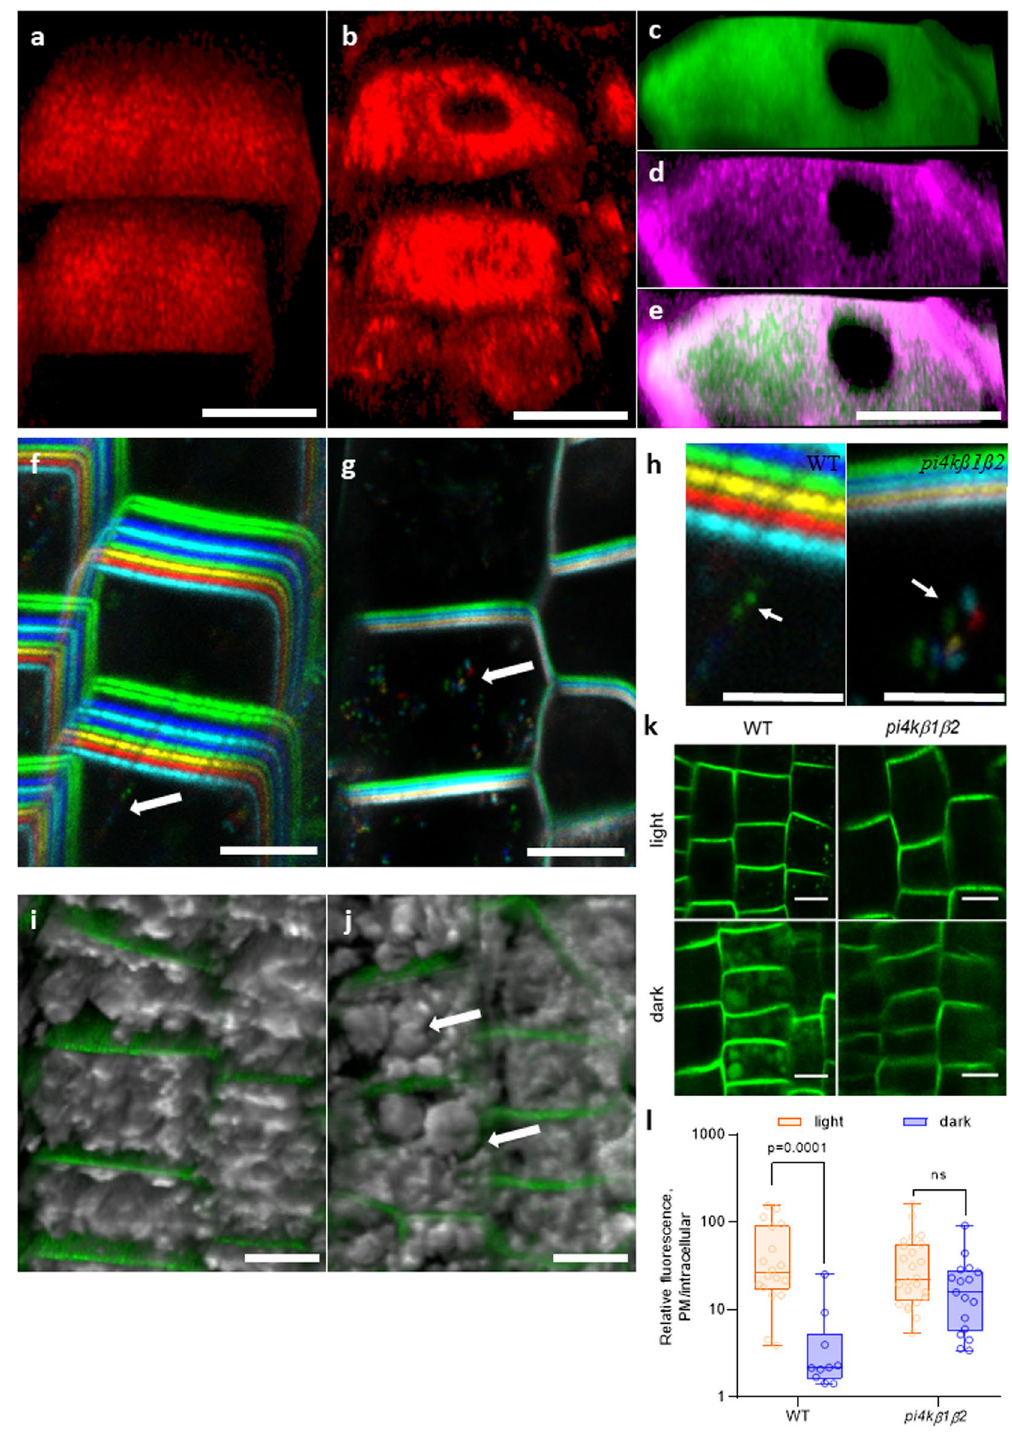
Figure 5. Visualization of PIN2-GFP subcellular distribution by confocal microscopy. ( a ) distribution of PIN2 along the PM in WT roots, immunostaining; ( b ) distribution of PIN2-GFP along the plasma membrane in pi4kß1ß2 roots, immunostaining; ( c,d,e ) show PIN2-GFP signal overlapping with FM4-64 dye, ( c , FM4-64; d , PIN2-GFP; e , merged signals); ( f,g ) color-coded projection of PIN2-GFP distribution and intracellular movement over time in ( f ) WT and ( g ) pi4kß1ß2 backgrounds; arrows point to vesicles moving in time; ( h ), zoomed part of f and g, scale bars 5 μm, arrows point to vesicles moving in time; ( i,j ) merged 3D reconstruction of pictures taken along the z-axis of the bright field and fluorescent channel of PIN2 distribution along the plasma membrane and vacuole morphology in ( i ) WT and ( j ) pi4kß1ß2 backgrounds; arrows point to enlarged vacuoles in pi4kß1ß2 ; ( k ) visualization of PIN2-GFP movement towards the lytic vacuole upon a dark shift of whole seedlings. After 1 h, the GFP signal was visible in the WT background, but not in pi4kß1ß2 ; ( l ) quantification of the GFP signal intensity in the lytic vacuole, each circle represents the plasma membrane/intracellular ratio for a single cell; p -value is indicated for significantly different groups, ns—non significant; unpaired t -test with correction for multiple comparisons; n = 25; scale bars 10